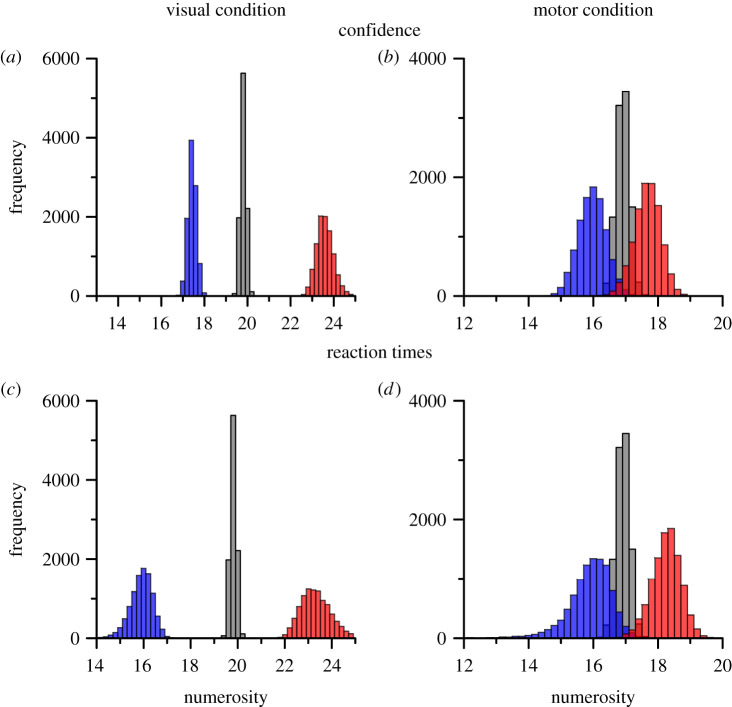
Frequency distributions of bootstraps for confidence (a,b) and reaction times (c,d), for visual or motor adaptation experiment (left and right panels, respectively). Data in blue represent visual baseline or slow tapping condition and red for high visual adaptation or fast motor tapping. Grey distributions show the bootstrapped mid-points between baseline (or slow) and adaptation (or fast tapping) PSEs. (Online version in colour.)